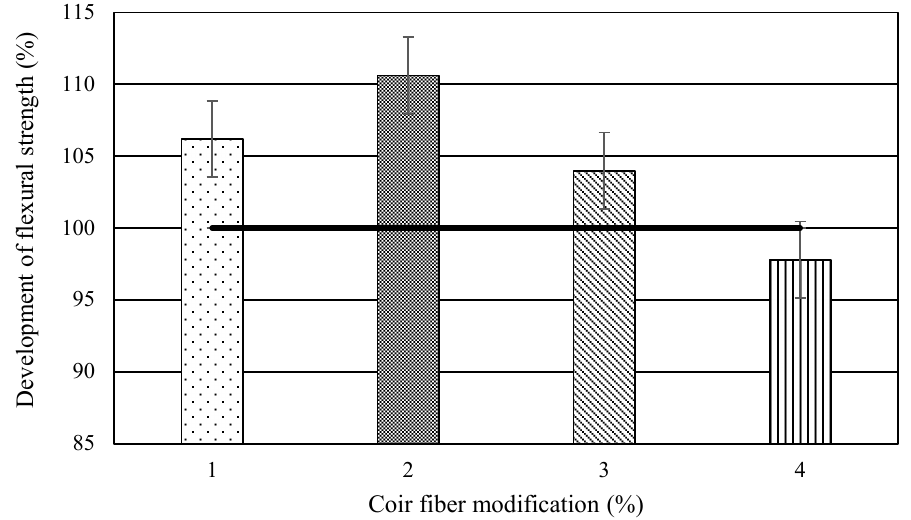
Figure 8. Development of flexural strength of coir fiber-modified concrete. Table 7. Flexural strength of concrete.